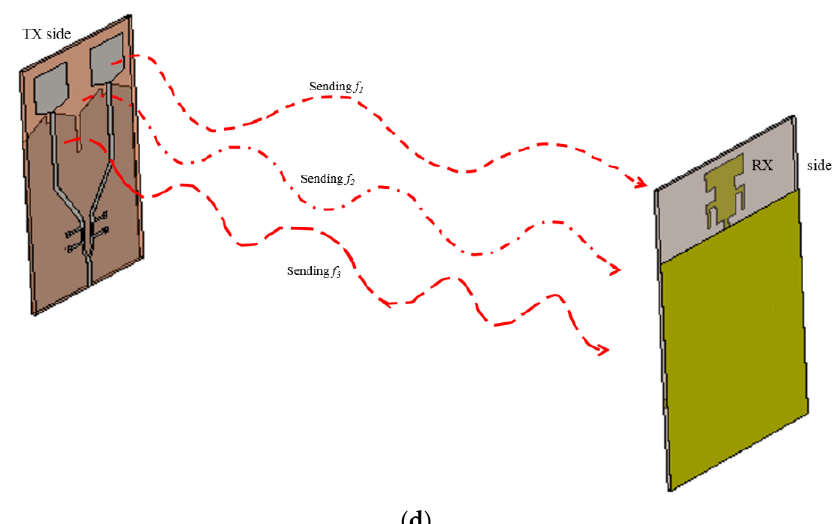
Figure 5. Shapes and interactive configuration of the TX and RX antennas. ( a ) A compact wide-band RX antenna and far-field patter for signal. ( b ) Front and bottom views of the wide-band TX antenna. ( c ) Wide-band RX antenna connected to multiplexer of three channel filters. ( d ) Scheme of linking the TX and RX antennas.